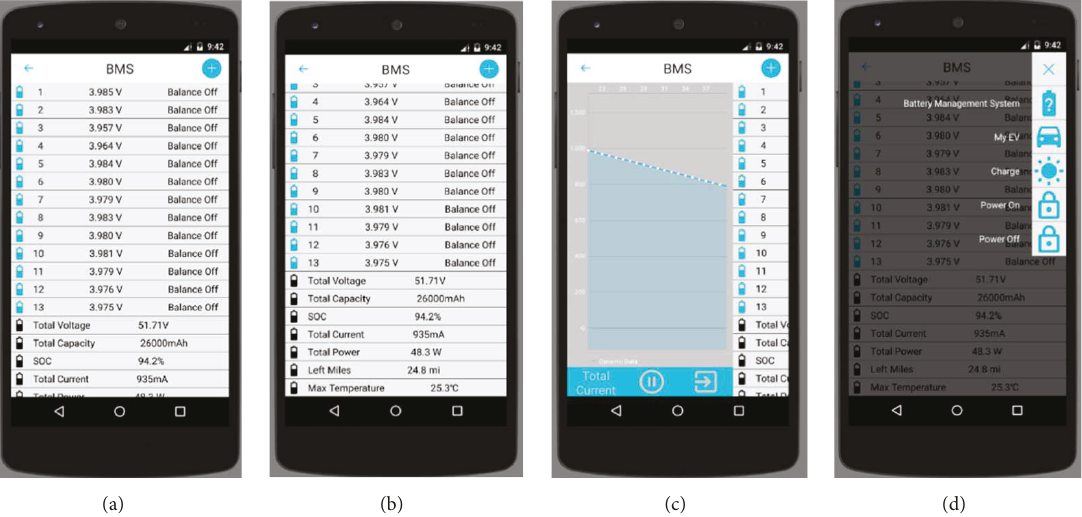
Figure 13: Monitor interface (a, b), data replay interface (c), and command send interface (d) on the Android